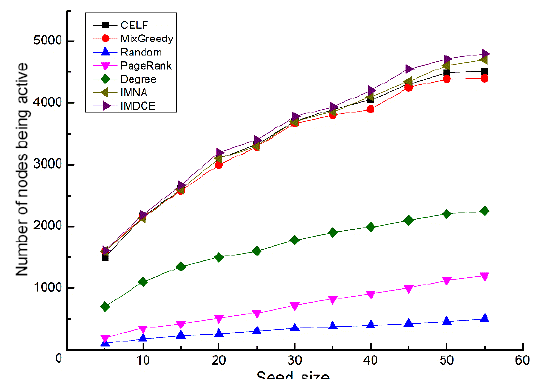
Fig. 6 Comparison of different algorithms on influence maximization.